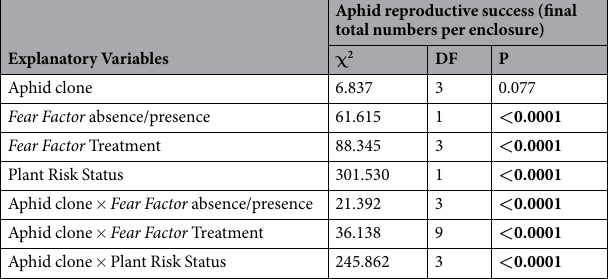
details on clonal differences in response to the different Fear Factor levels. Comparatively, under the influence of the non-lethal (non-consumptive) Fear Factors (FF3 - FF4), all clones except, clone one, showed a general pattern of impeded reproductive success i.e . the clones differentially displayed reduced production of progeny in com- parison to the FF0 reference frame. Moreover, the effect of FF3 varied across clones and was notable on clone four (22.41 Pi point drop in aphid performance rank, if compared with the reading under FF0), (Fig. 1). Conversely, FF3 was the least effective in suppressing aphid numbers in clone one, (Fig. 1); see also supplementary materials (Appendix 1). Moreover, treatment FF2 of the applied non-lethal predator cues was the first most efficacious in suppressing aphid reproductive success in a clone specific fashion, followed by FF4. On average, aphids of the four clones reproduced less when dead predators were present in FF2 and their responses varied considerably. The risk in FF2 (visual-olfactory in nature) had the most negative effect on clone one (4.42 Pi ) followed by clone four (4.92 Pi ), (Fig. 1). All in all, treatment FF4 (soil-infused cues) had a larger negative effect on aphid performance than FF3 (shoot-sprayed cues). Interestingly, aphids of clone one thrived under FF3 and FF4, contrary to the poorer